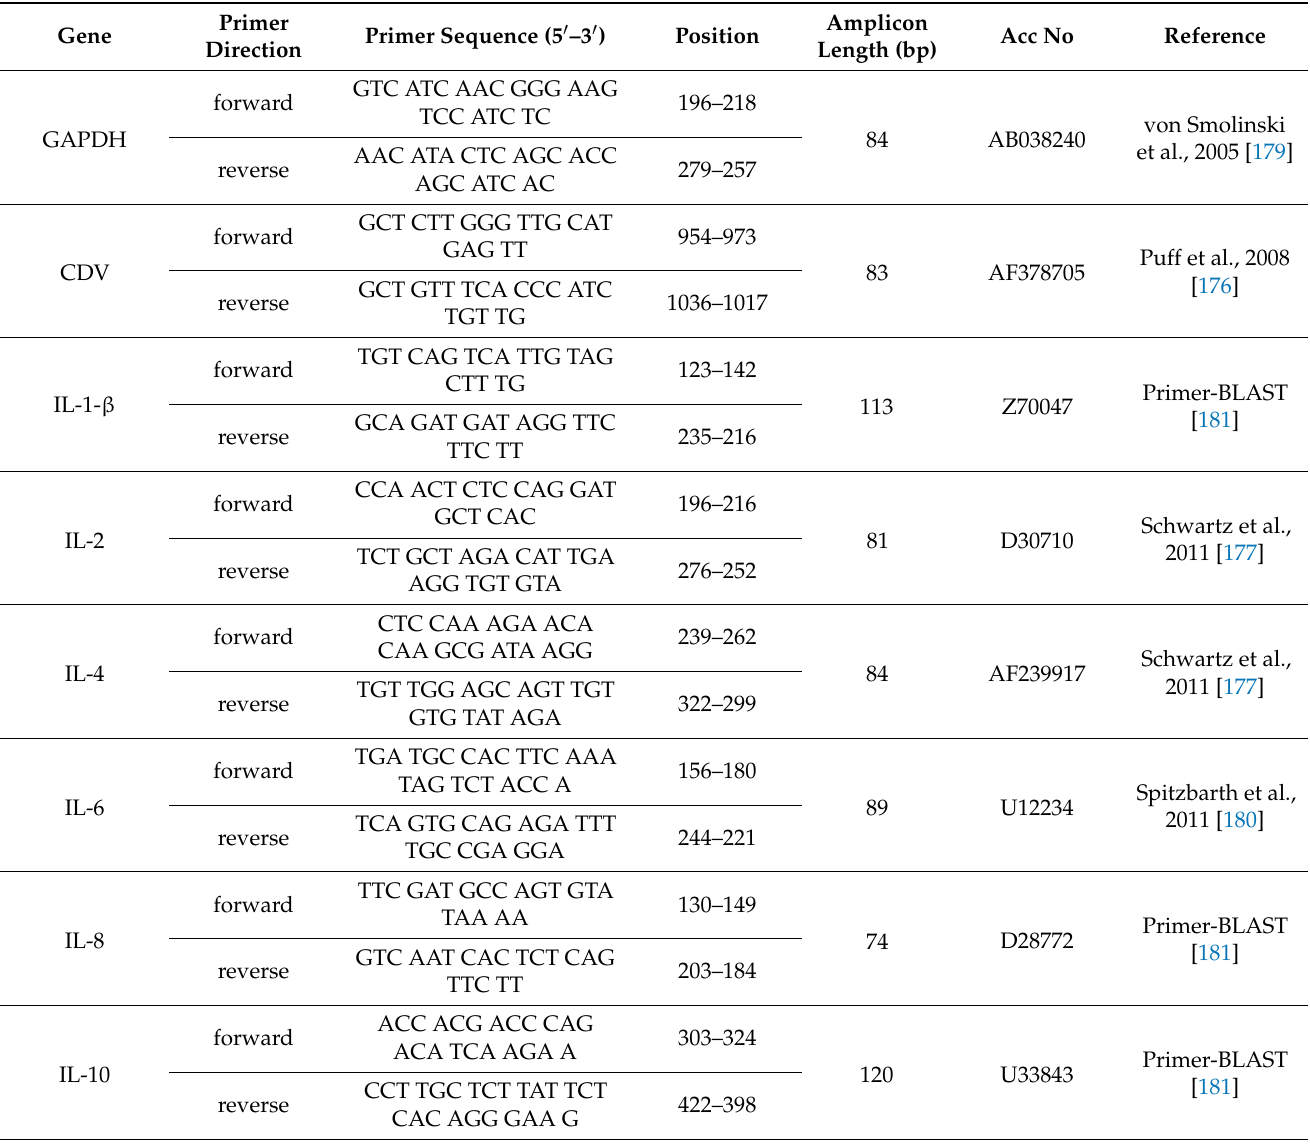
Table 5. Primers used for